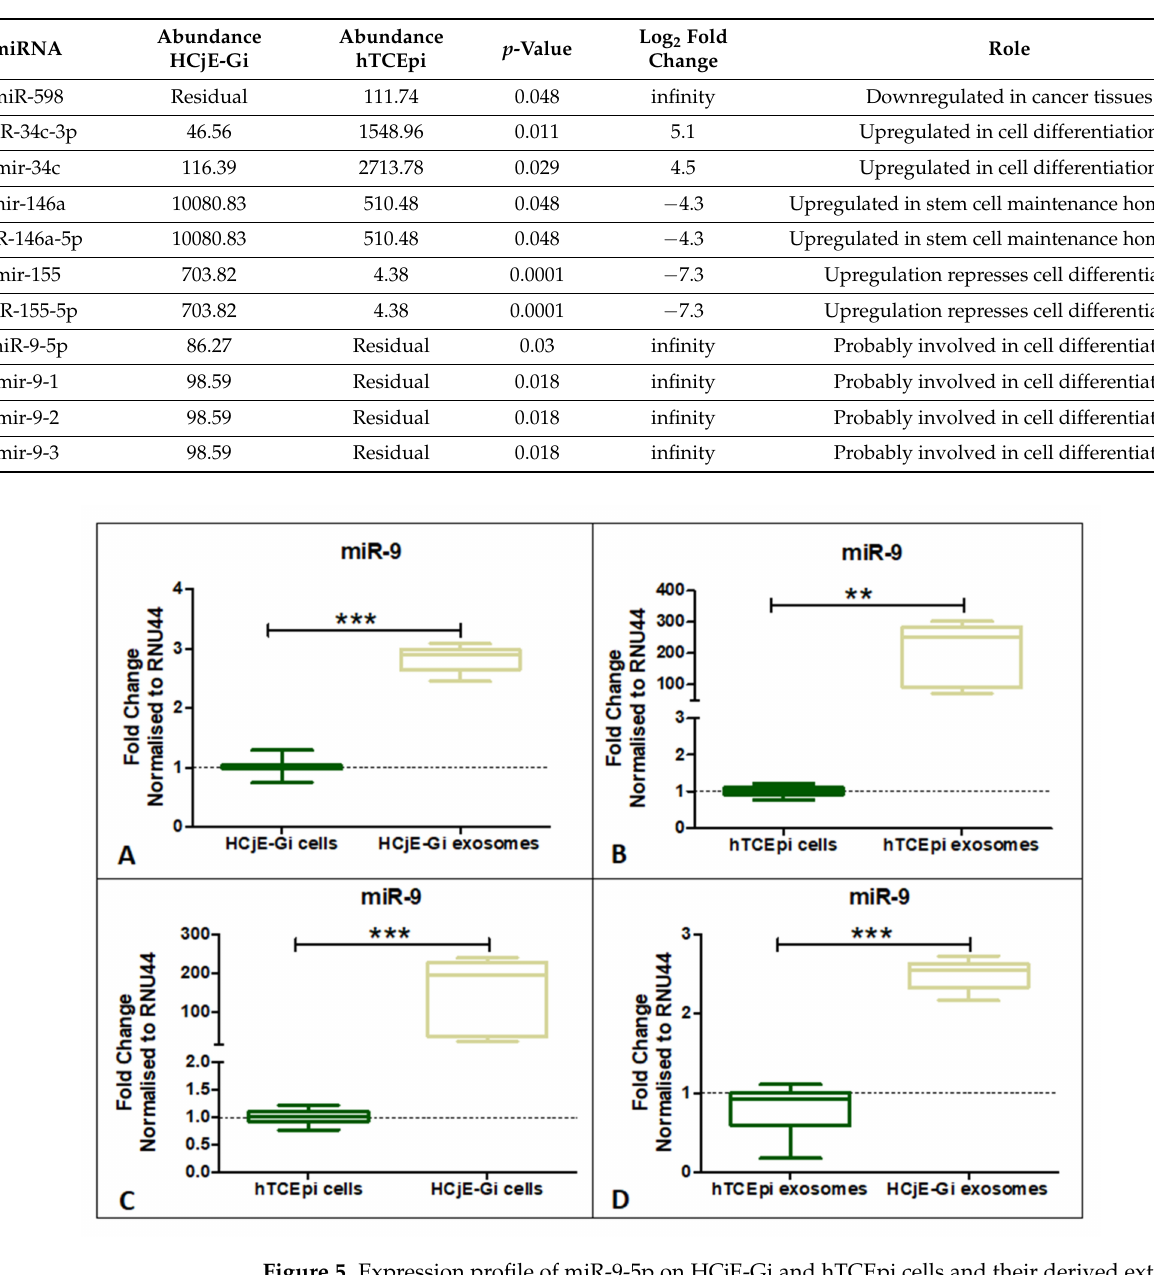
Figure 5. Expression profile of miR-9-5p on HCjE-Gi and hTCEpi cells and their derived extracellular vesicles. miR-9-5p showing significantly higher expression in ( A ) HCjE-Gi and ( B ) hTCEpi cell- derived exosomes. ( C ) miR-9-5p showing higher expression in HCjE-Gi cells compared to hTCEpi cells. ( D ) miR-9-5p expressed more in HCjE-Gi exosomes compared to hTCEpi exosomes. (Data is represented as median ± 5–95 percentile, n ≥ 3, Mann–Whitney test, Bonferroni-corrected p -value, ** p < 0.01, *** p <